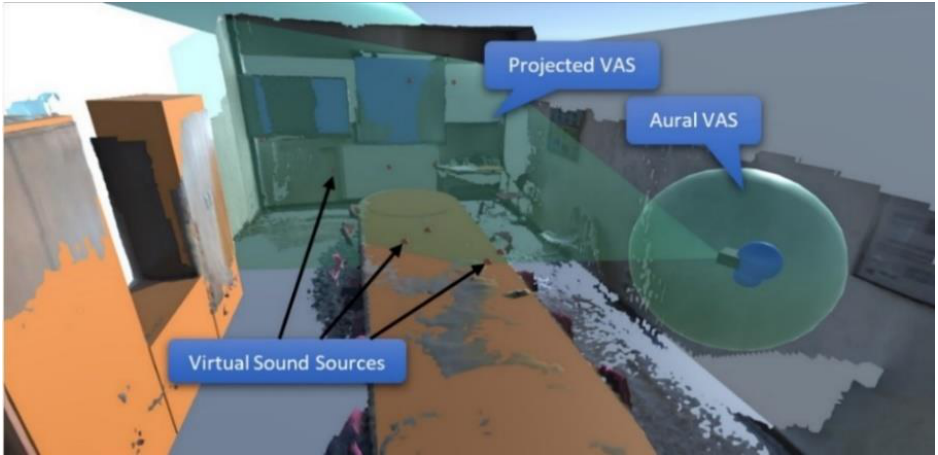
Figure 3. Projected and Aural VAS.